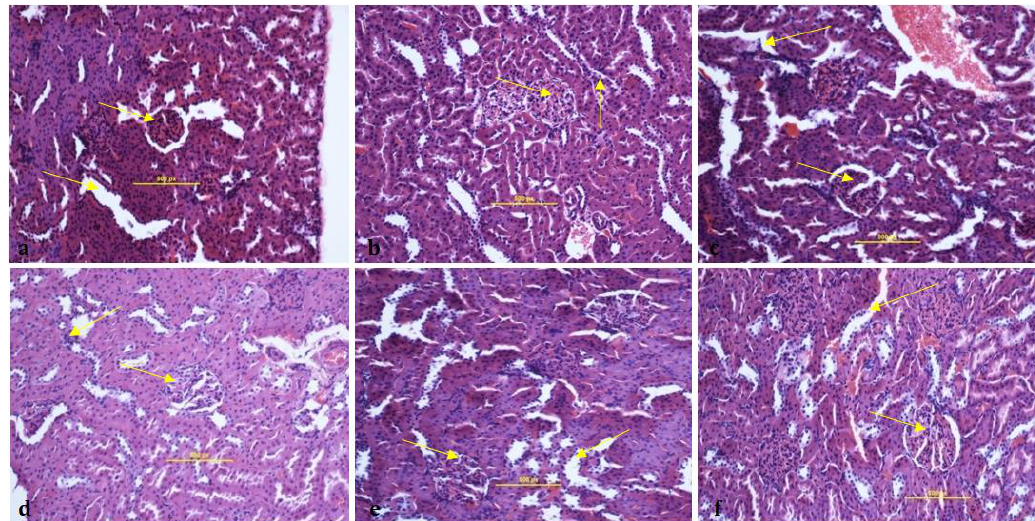
Figure 5 Histopathological changes in the kidney of normal and experimental rats. All the sections are in H&E 40X. (a) Control rat (kidney shows normal glomeruli and tubules) (yellow arrow). (b) Diabetic rat kidney. Glomeruli with mesangiocapillary proliferation (yellow arrow). (c) Diabetic rat + 100 mg/kg of MPMTE. Glomeruli with mesangiocapillary proliferation (yellow arrow). (d) Diabetic rat + 200 mg/kg of MPMTE (Tubules shows proteinuria and glomerular damage) (yellow arrow). (e) Diabetic + 400 mg/kg of MPMTE (shows glomeruli and tubules without proteinuria and hemorrhage) (yellow arrow). (f) Diabetic + 100 mg/kg of Metformin (shows glomeruli and tubules without proteinuria and hemorrhage) (yellow